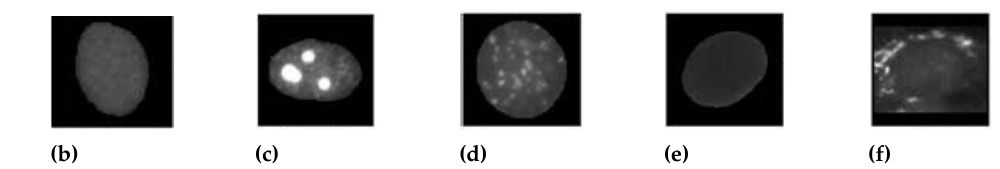
Figure 4. Cell staining included six pattern in the dataset: ( a ) homogeneous (Hm), ( b ) speckled (Sp), ( c ) nucleolar (Nu), ( d ) centromere (Cn), ( e ) nuclear membrane (Nm), and ( f ) Golgi